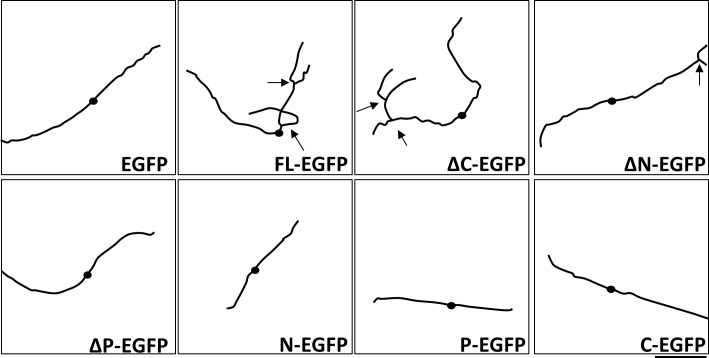
Traces of axonal morphology shown in Figure 1B. Scale bar: 200 µm.